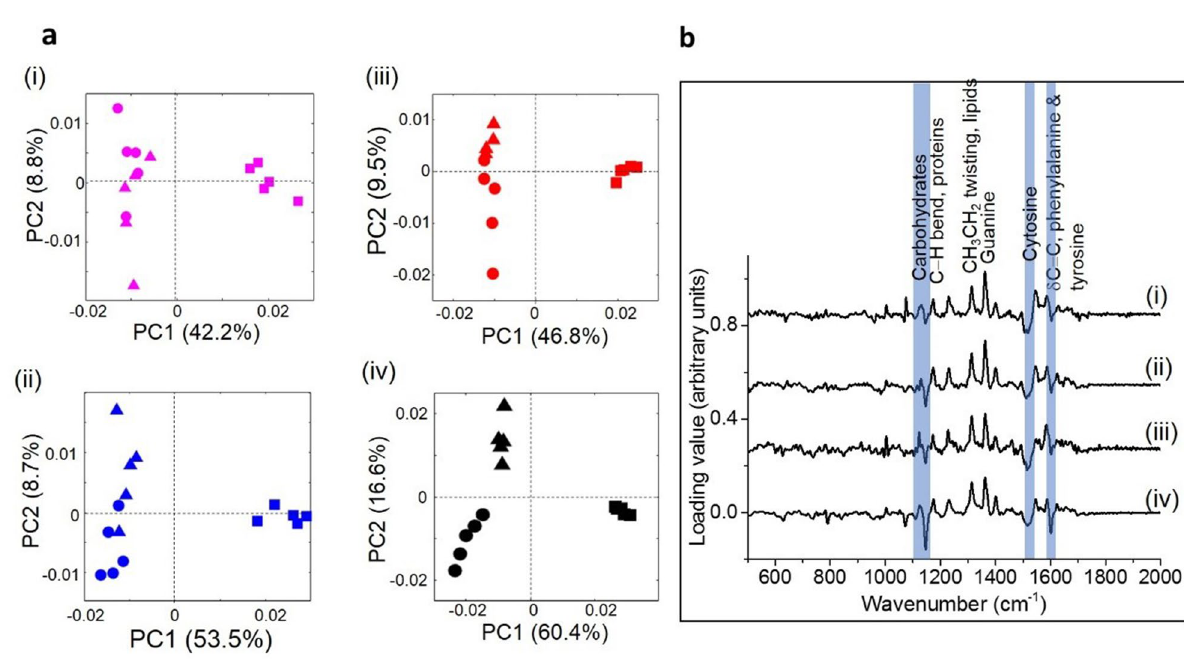
Figure 8. ( a ) Scatter plots of principal component analysis of the Raman spectra from planktonic cells and biofilms of the four bacterial strains: (i) P. fragi 1793, (ii) P. fragi 1832 , (iii) P. lundensis 1822 and (iv) P. lundensis ATCC 49968. (square, planktonic cells; circle, biofilms grown at 10 °C; triangle, biofilms grown at 25 °C). ( b ) The loading plots. The corresponding PC1 loading plots of each strain exhibit the spectral differences of each comparison: (i) P. fragi 1793, (ii) P. fragi 1832, (iii) P. lundensis 1822 and (iv) P. lundensis ATCC